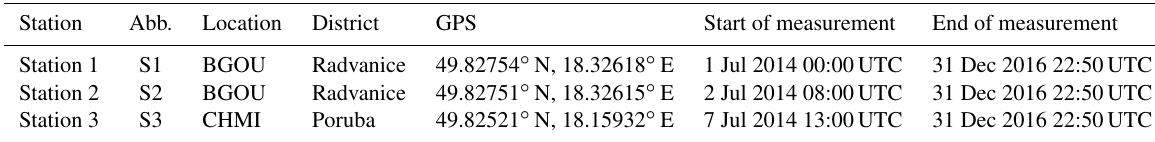
Table 1. List of measuring stations owned by the University of Ostrava with some details. BGOU means Botanical Garden of University of Ostrava, CHMI means Czech Hydrometeorological Institute. Station Abb.